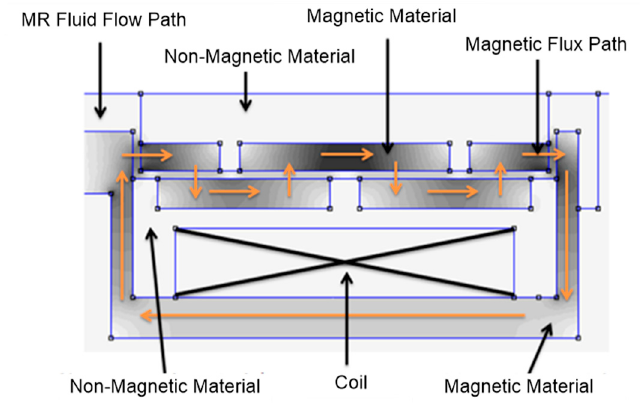
Figure 3. Magnetic flux flow path of the serpentine valve.